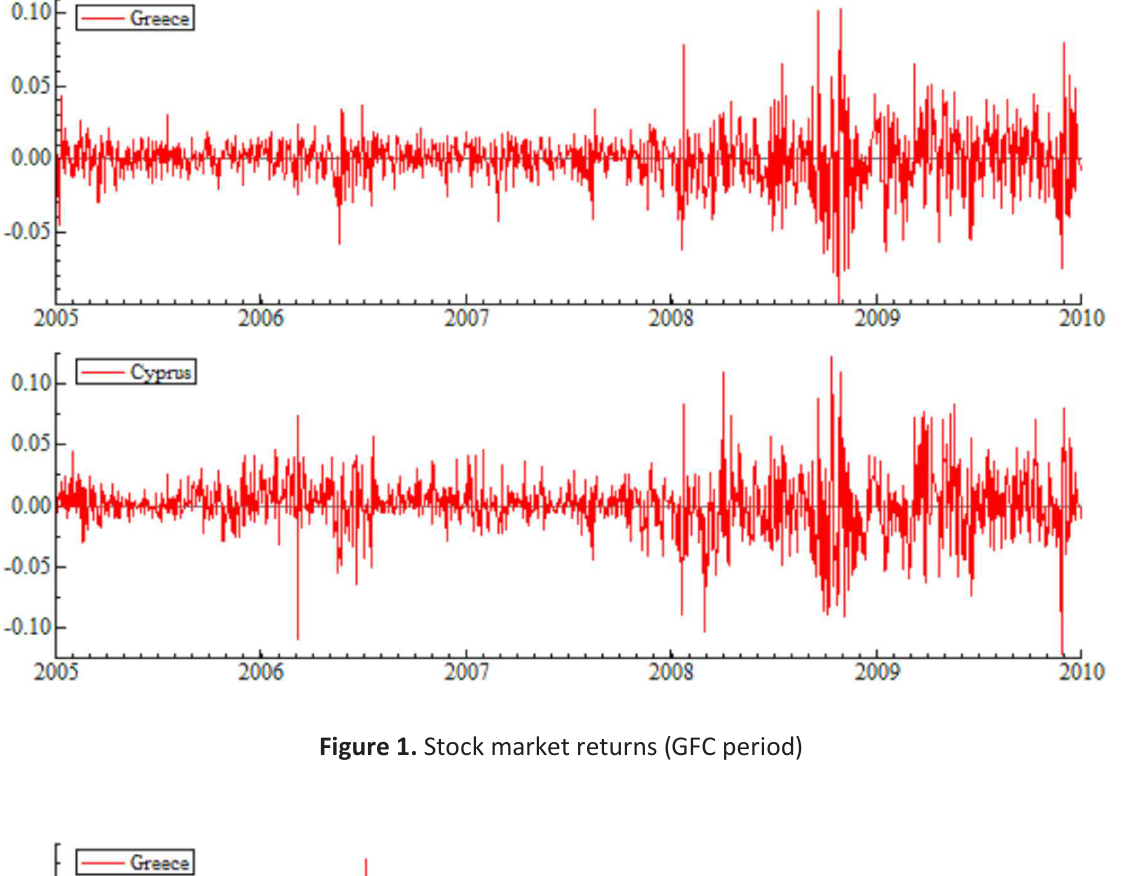
Figure 1. Stock market returns (GFC period)